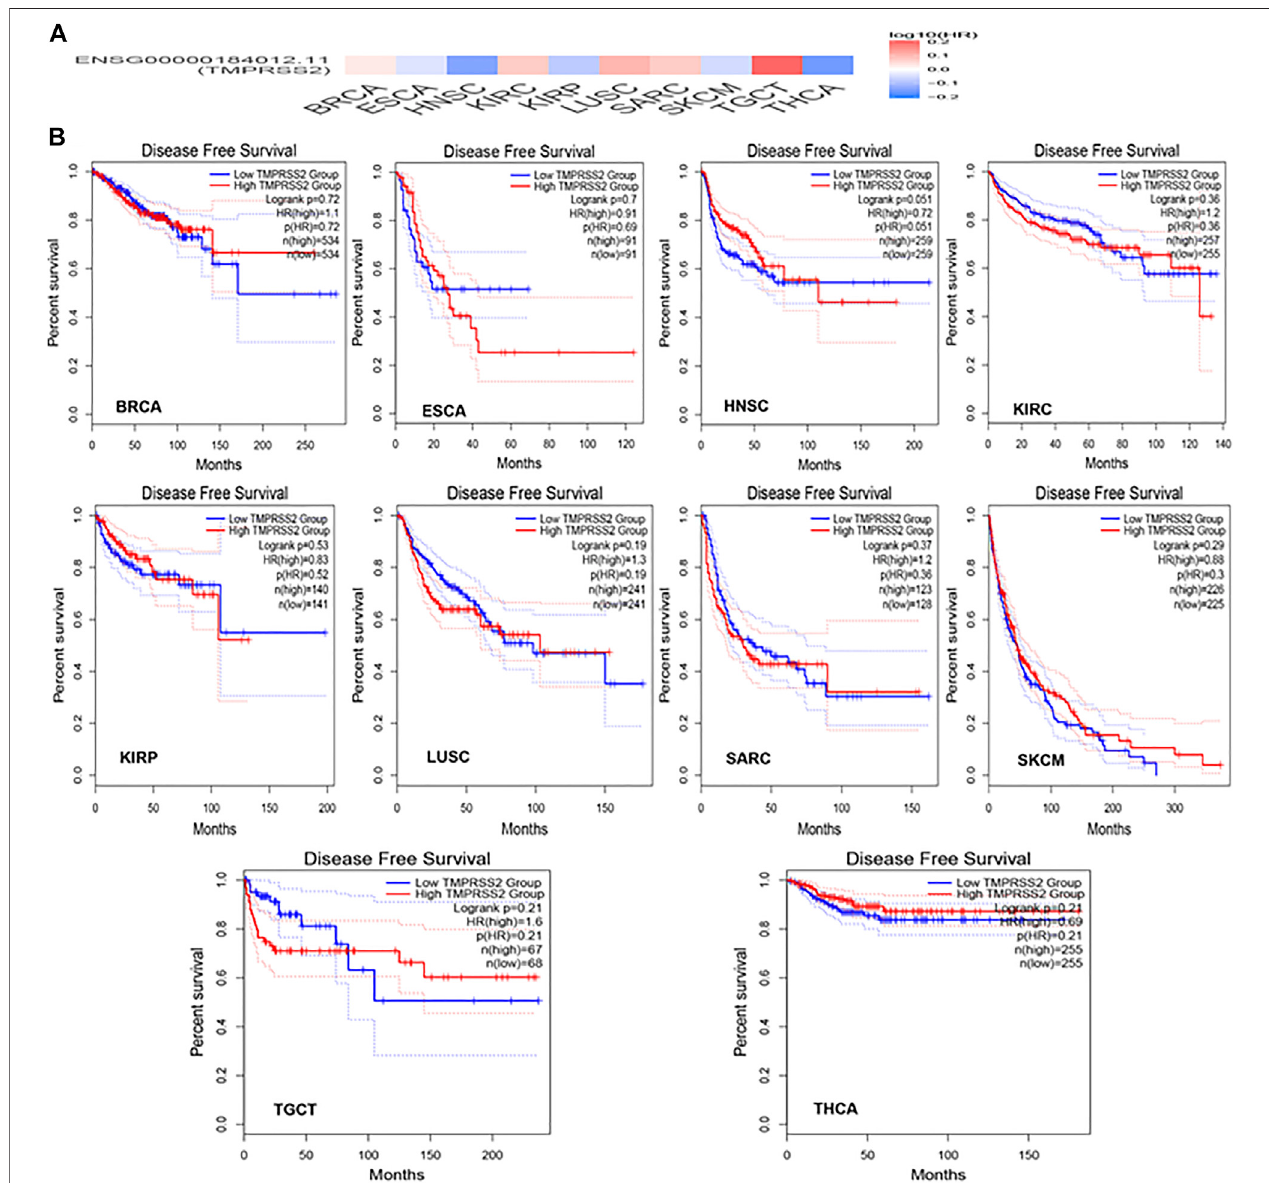
FIGURE 7 | Correlation between genetic disorders and TMPRSS2 expression. (A) In most cases, there was no statistical correlation between DNA copy variation and RNA TMPRSS2 expression. (B) The mutation has nothing to do with RNA expression.